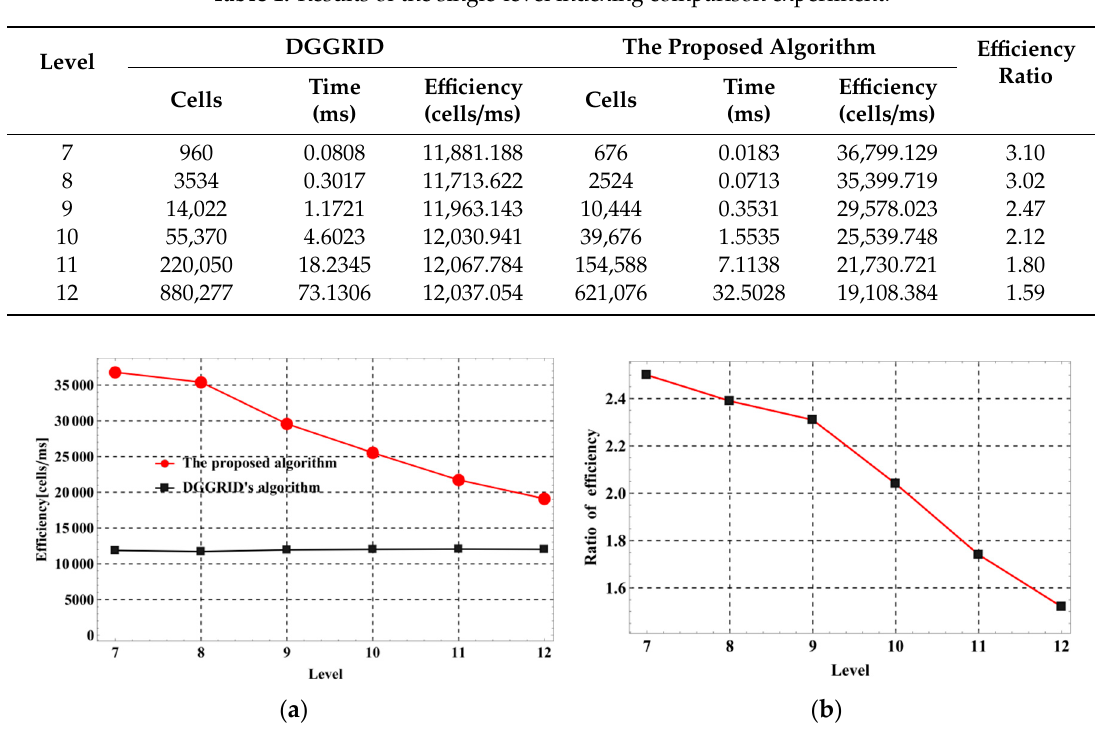
Figure 11. Efficiency comparison line charts for single-level indexing: ( a ) absolute value and ( b ) ratio. Table 2. Results of the hierarchical indexing efficiency comparison experiment.